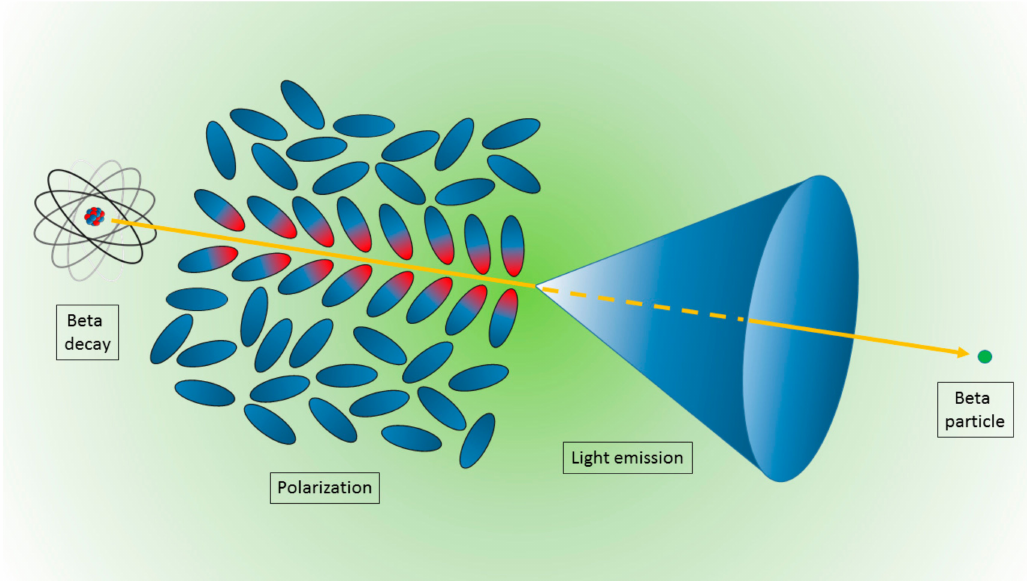
Figure 1. Schematic representation of the Cerenkov light emission process. A beta particle, emitted by a radionuclide, travels in a medium faster than the light speed in the medium itself. The fast de-polarization of the molecules produces a cone of light known as Cerenkov